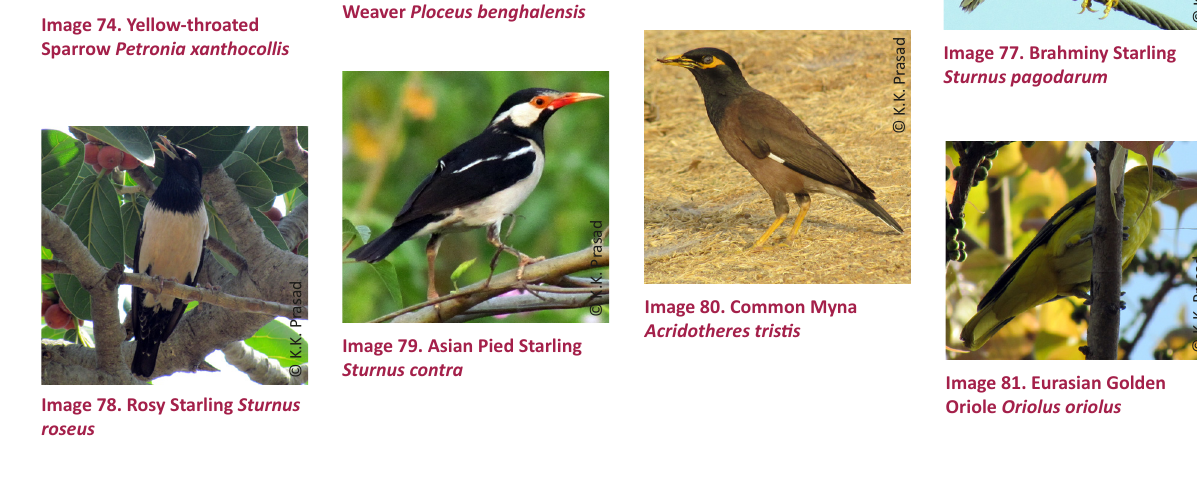
Image 75. Black-breasted Weaver Ploceus benghalensis